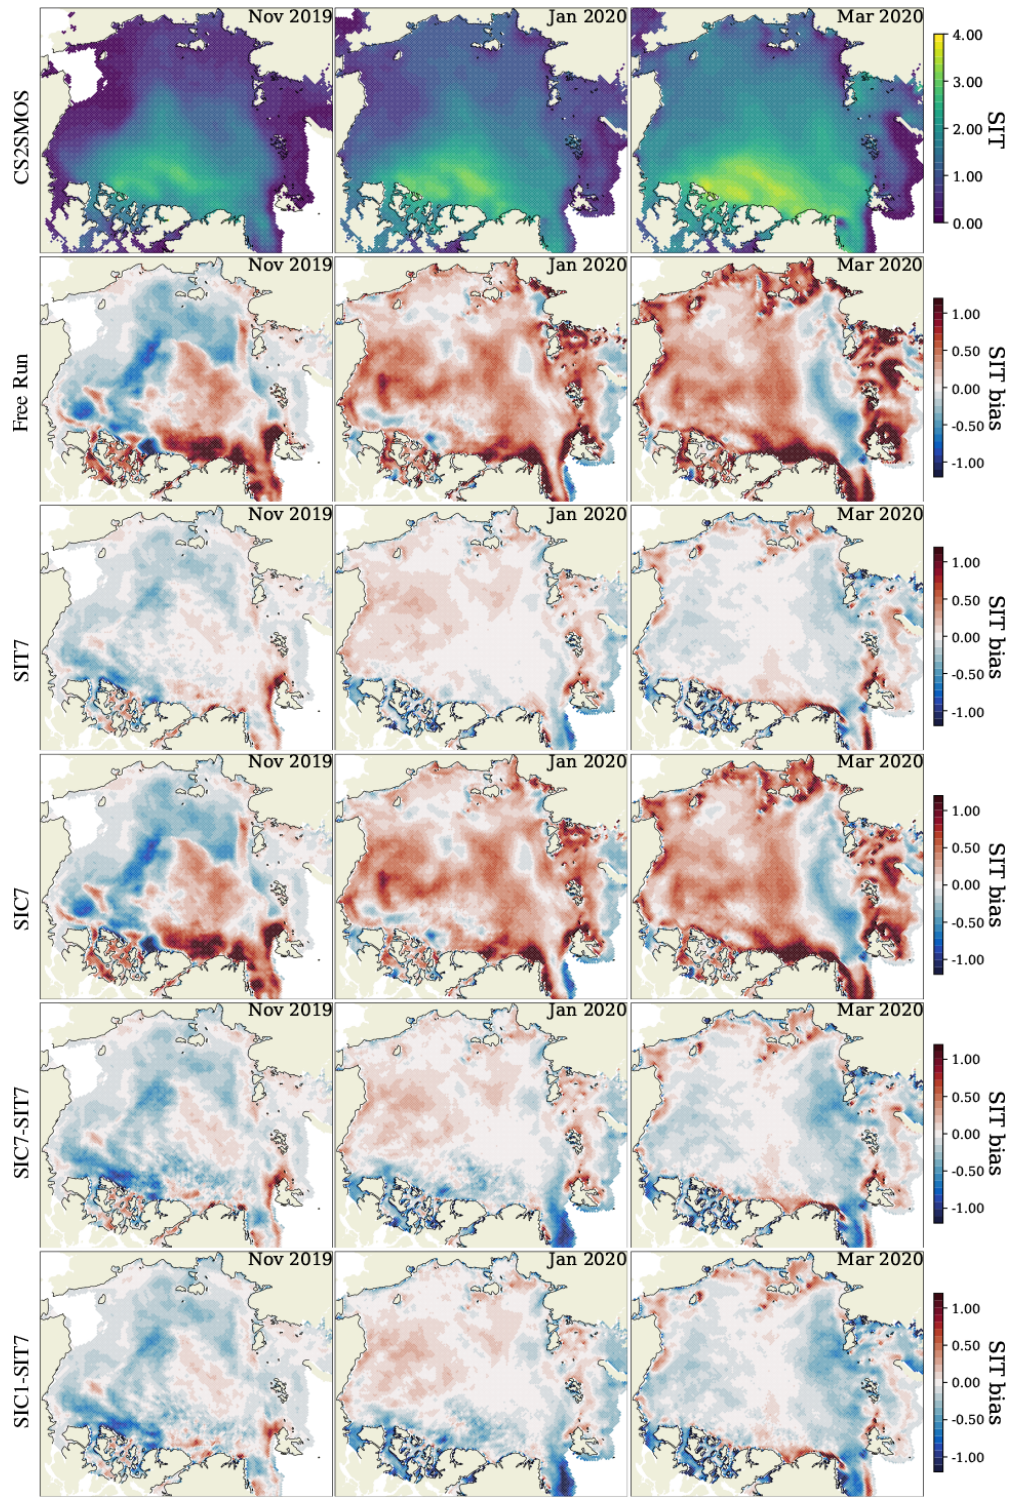
Figure 5. Monthly average of SIC observations (first row) and SIC bias between the model forecasts and the OSI-SAF SIC product. Panels from left to right are November 2019, January, and March 2020. Red and green lines are the sea ice edges (applying the classical threshold of 15% SIC) from the observations and the ensemble mean